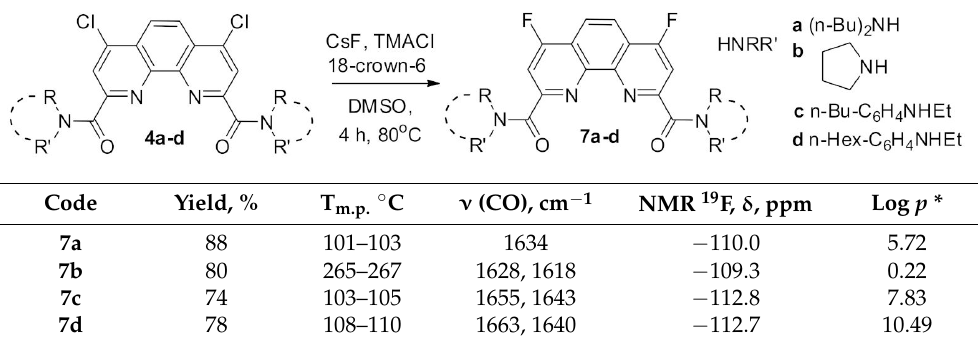
Table 1. Yields and some properties of difluoro ligands 7a – d